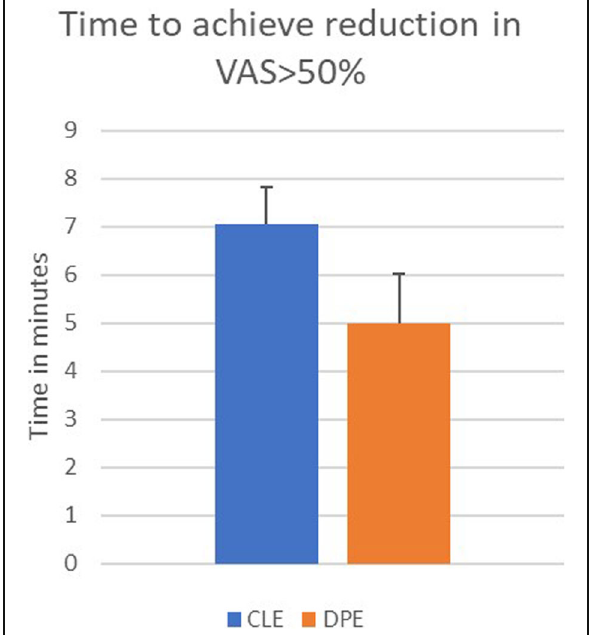
Fig. 3 Time to achieve VAS ≤ 3 in the study groups; in group CLE, it was 14.93 ± 1.98 min, and in group DPE, it was 10.13 ± 1.45 min ( p < 0.0001). CLE conventional lumbar epidural, DPE